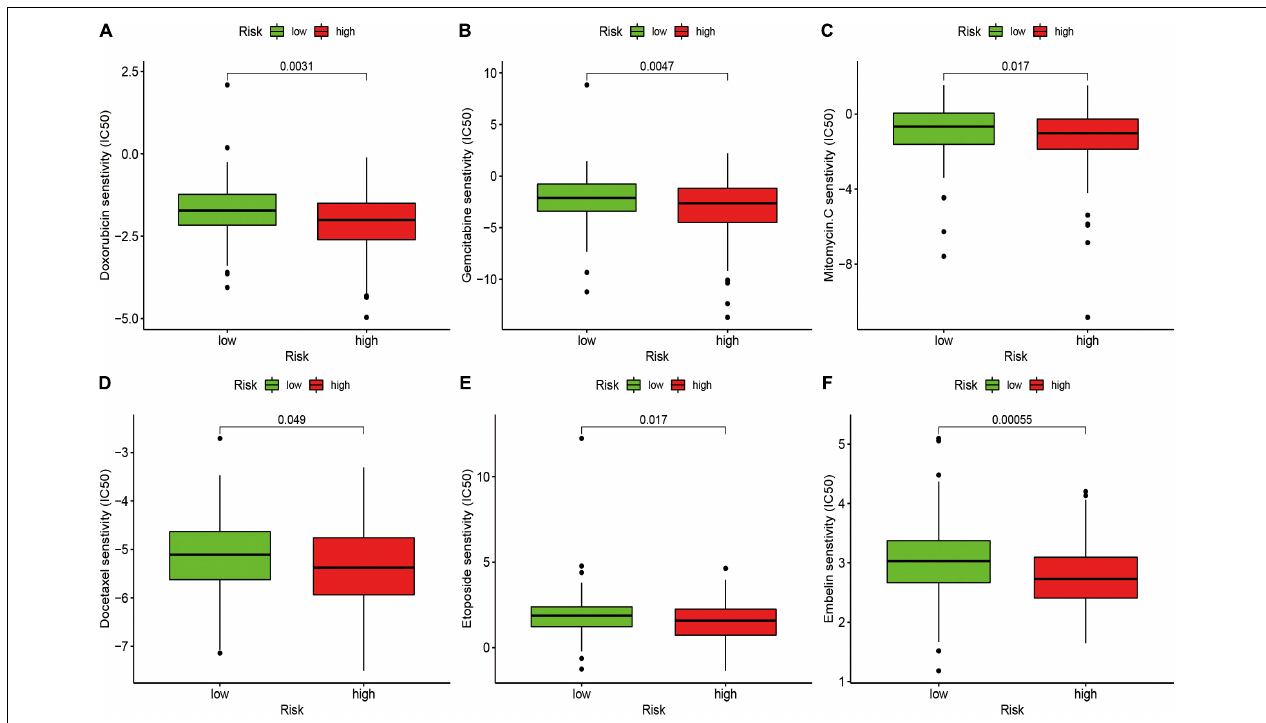
FIGURE 6 | Estimation of the Associations between Chemosensitivity and the Risk Signature. The ICI50 of (A) doxorubicin, (B) gemcitabine, (C) mitomycin C, (D) docetaxel, (E) etoposide, and (F) embelin in the high-risk and low-risk groups. The risk signature acted as a potential predictor for chemosensitivity as high-risk scores were associated with a lower IC50 for chemotherapeutics including doxorubicin, gemcitabine, mitomycin C, docetaxel, etoposide, and embelin.